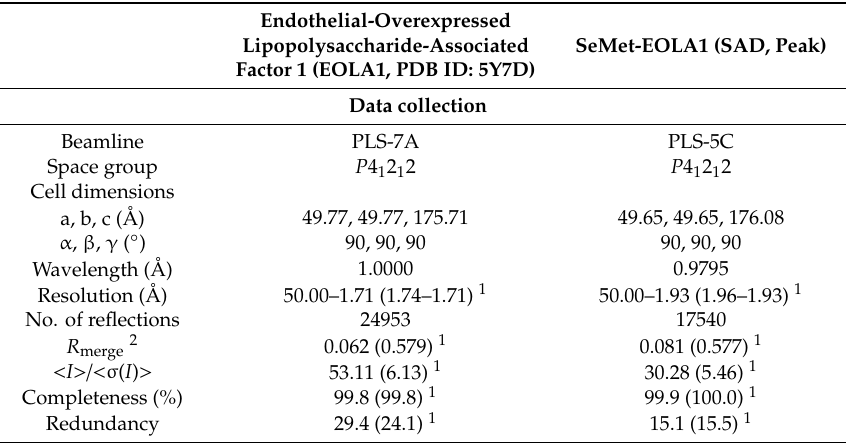
Table 1. Statistics for data collection and model